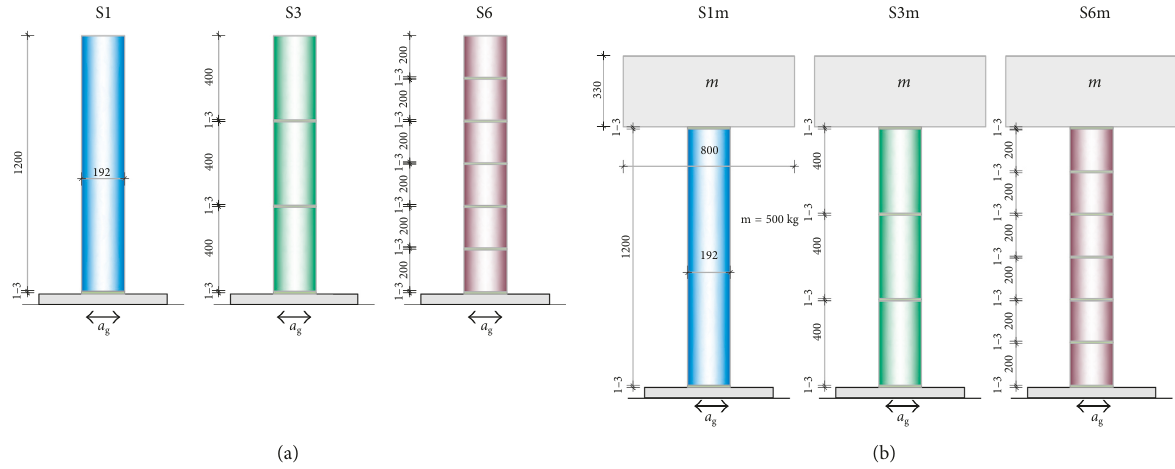
Figure 1: Tested free-standing columns: (a) self-weight only and (b) self-weight and mass at the top.